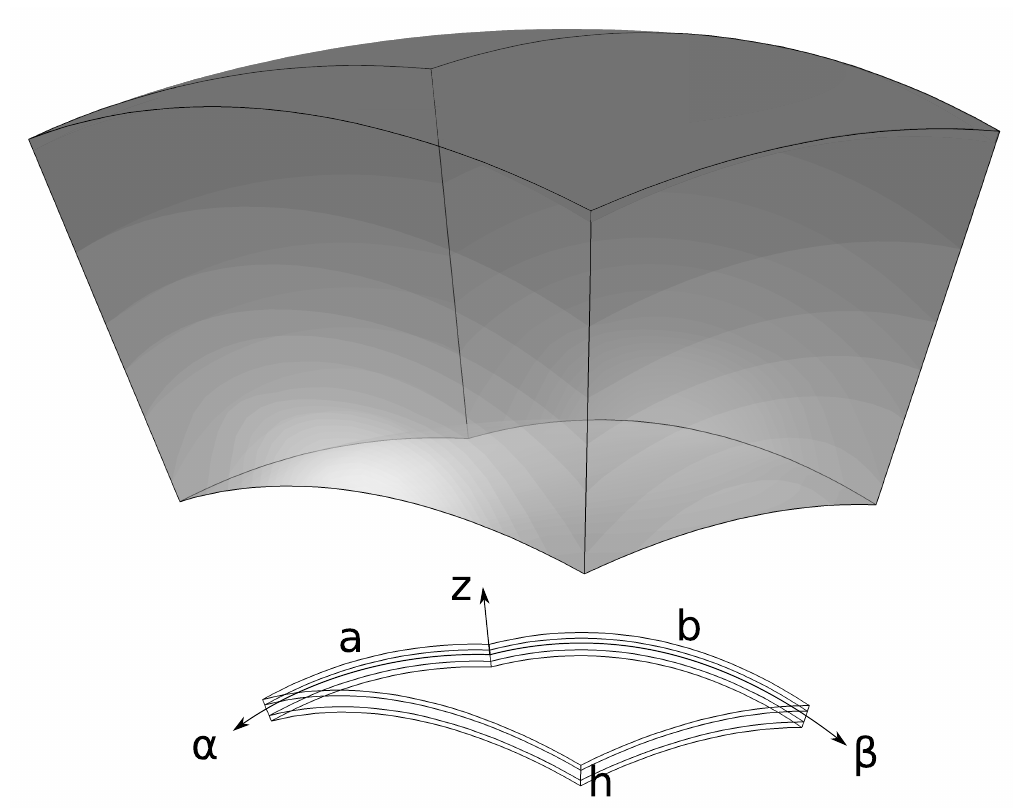
Figure 7. Reference system and geometry of the spherical sandwich viscoelastic shell with metal skins and the transmitted sound pressure field. Table 2. Geometrical and material data for the isotropic sandwich